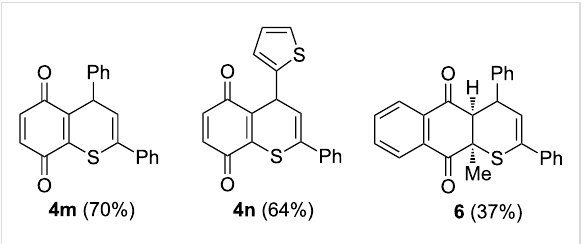
Figure 2: Products of the reactions of thiochalcones 1a and 1b with 1,4-benzoquinone ( 2a ) and of 1a with menadione ( 2e ).